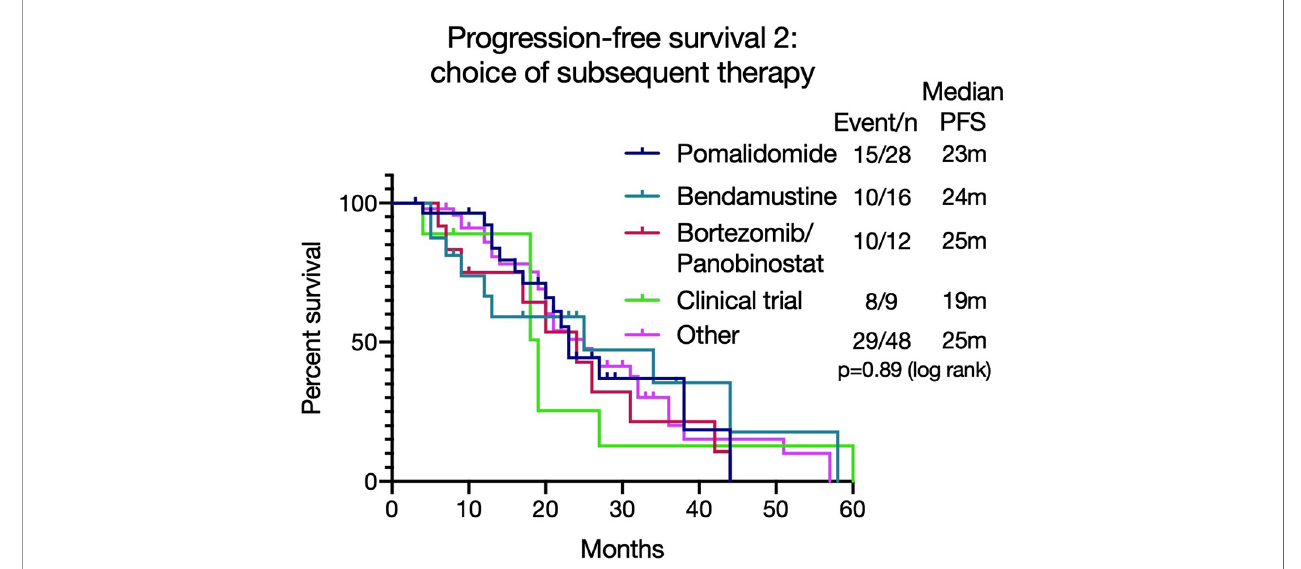
FIGURE 4 | Progression free survival 2 [PFS2 - from commencing lenalidomide to progression on next line of therapy (T1)] based on different treatment choices after lenalidomide-based therapy. The median PFS2 was similar irrespective of treatment choice